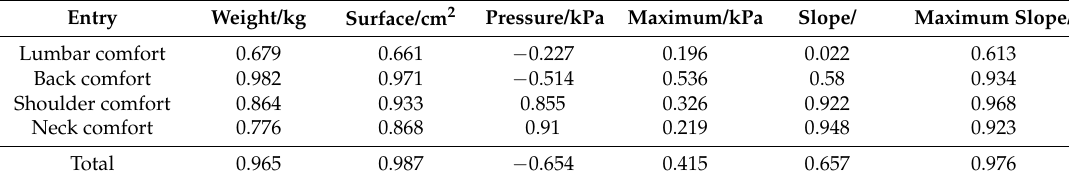
Table 2. Correlativity between subjective and objective evaluation results